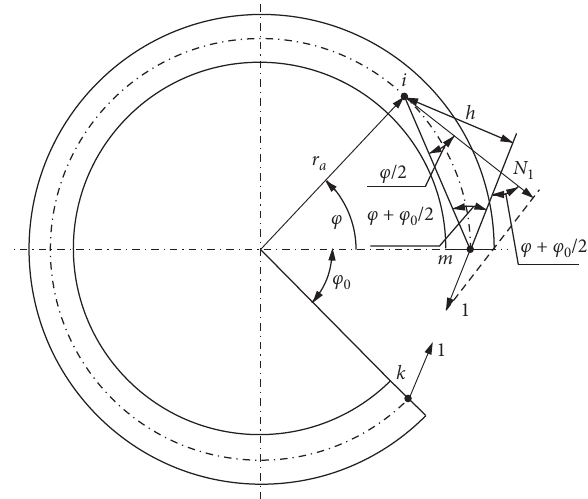
Figure 4: Unit load diagram of the ring.